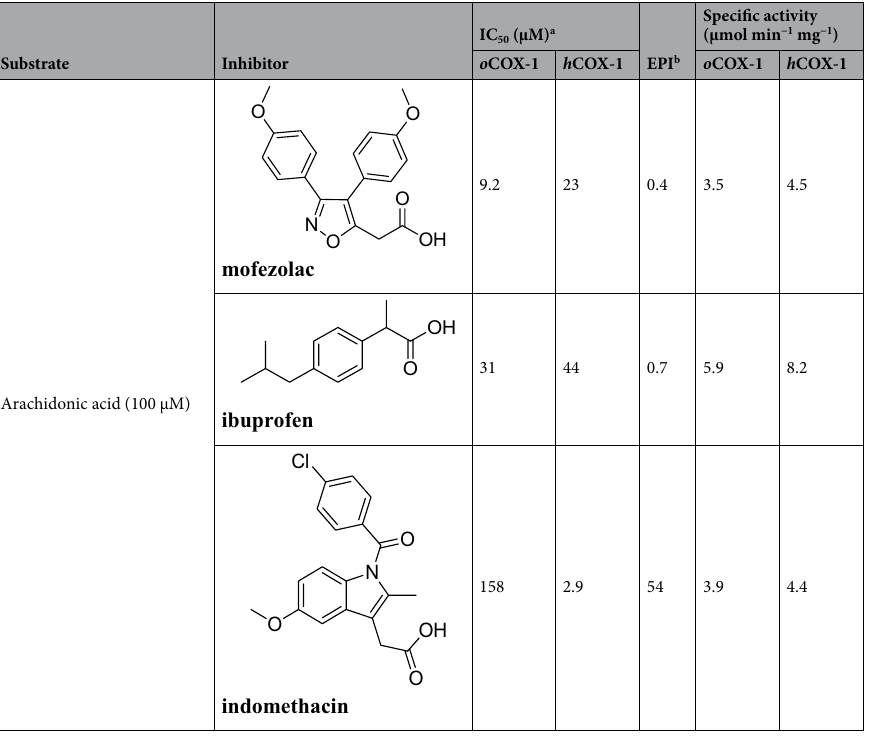
Table 1. o COX-1 IC 50 and h COX-1 IC 50 , and the specific activity of the two enzymes. a Determined by Cyclooxygenase O